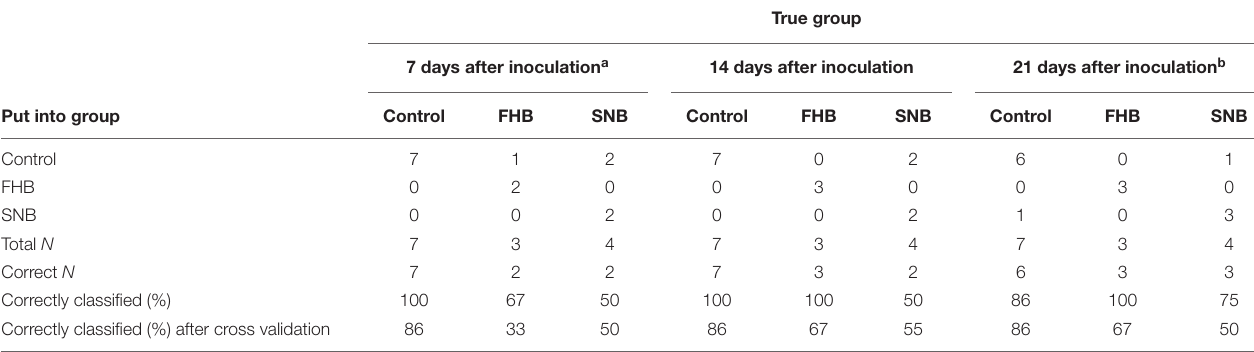
TABLE 7 | Summary of classification of fungal diseases on ‘Zebra’ with “disease” [control, Fusarium head blight (FHB), and Septoria nodorum blotch (SNB)] as the response and different VOCs as predictors. True group 7 days after inoculation a 14 days after